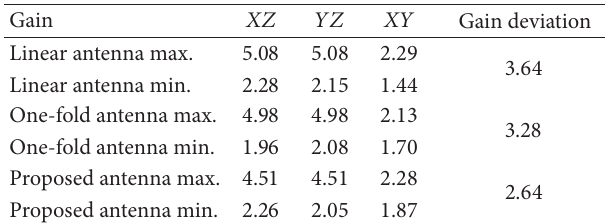
Table 1: Simulated gain values in three planes of the three tag antennas (Unit: dB). Gain 𝑋𝑍 𝑌𝑍 𝑋𝑌 Gain deviation Linear antenna